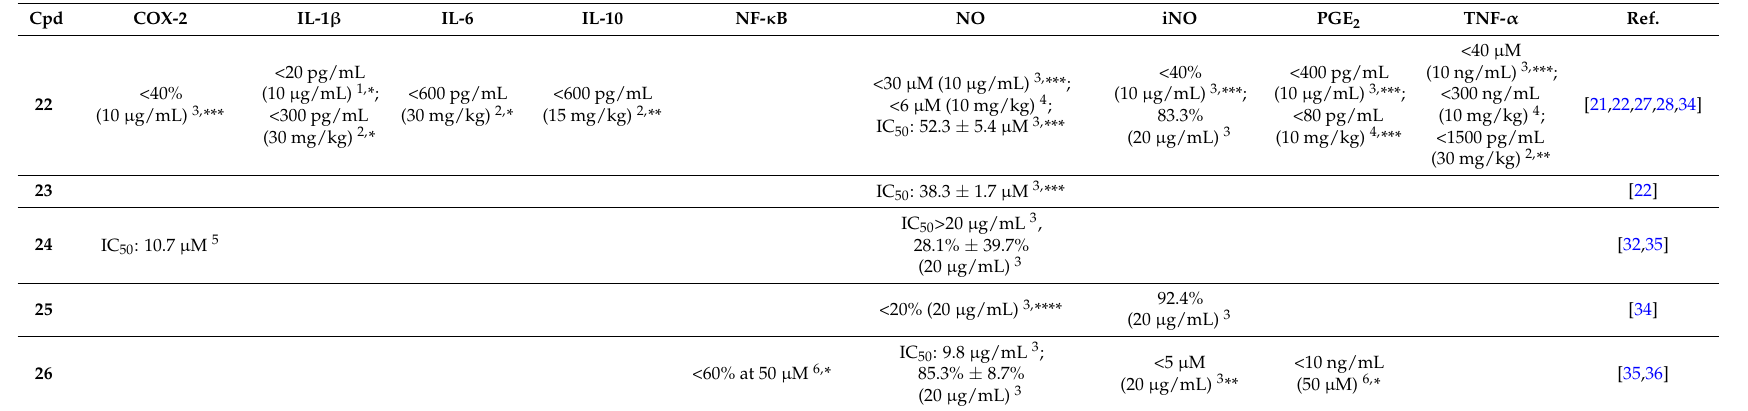
Table 2. Some anti-inflammatory activities of furocoumarins.